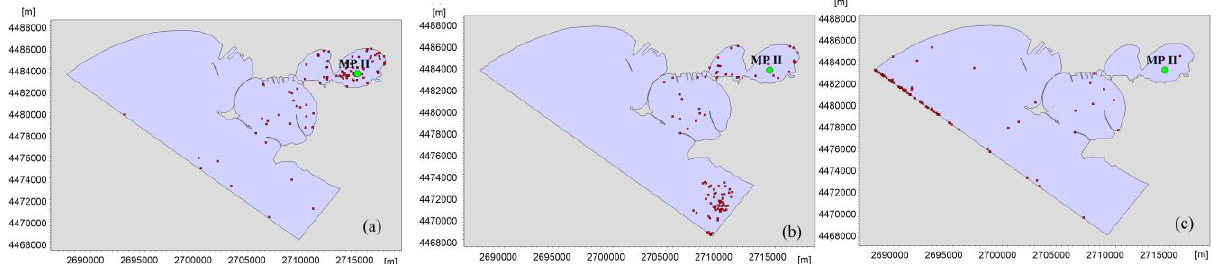
Figure 18. Percentage PT5 (MP II) — the cloud of particles: ( a ) 30 days after release; ( b ) 60 days after release; ( c ) 90 days after release at surface layer.